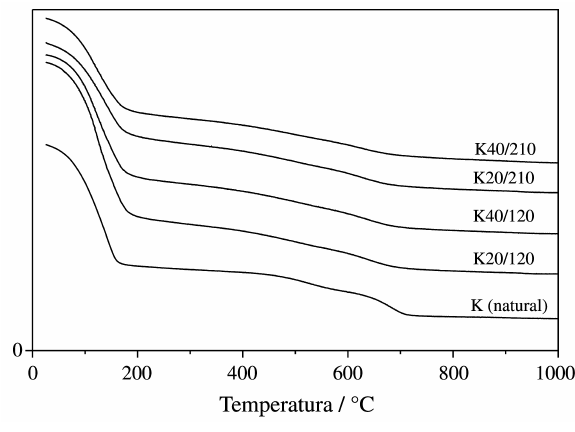
Figura 2. Curvas TG das amostras natural e